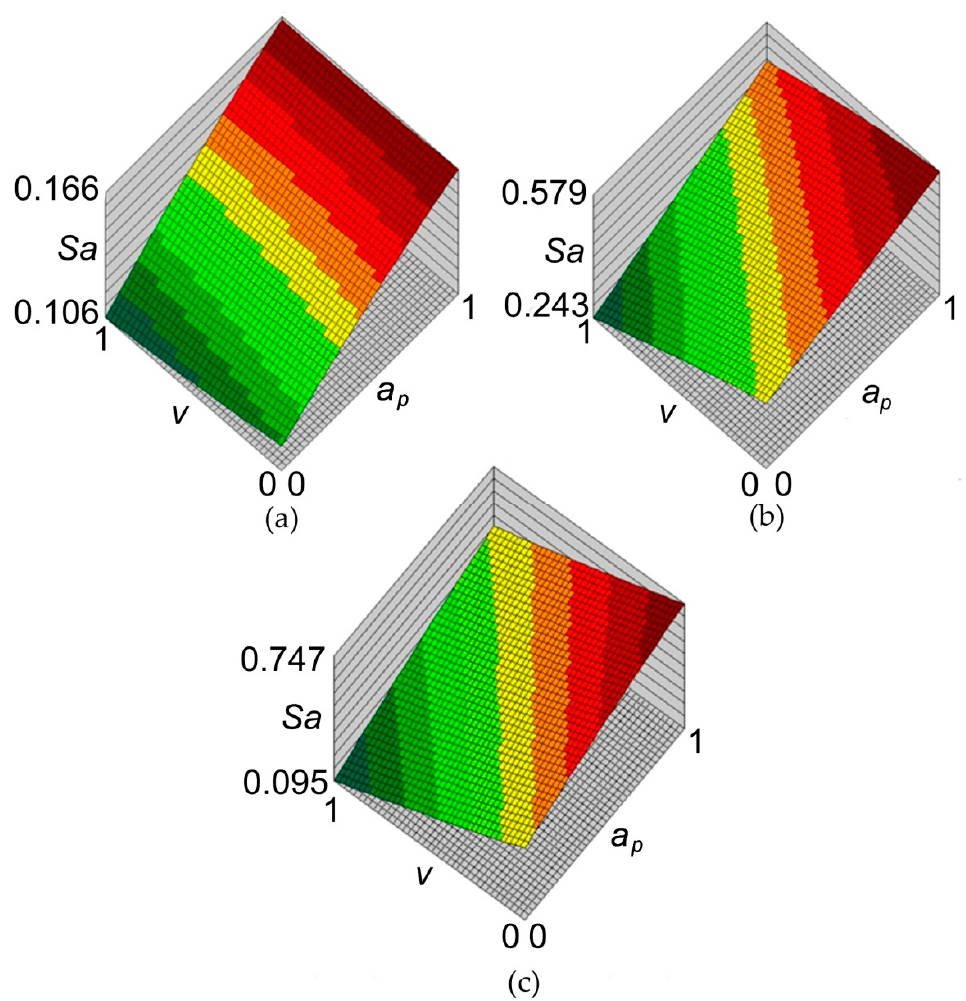
Figure 9. Response surfaces of the neural network 2:2-8-1:1 concerning the influence of incremental vertical step size a p and the tool rotational speed v on the value of the 10-point peak–valley surface roughness Sz (normalised data) for sheets: ( a ) 0.4-mm-thick EN AW-2024-T3 Alclad, ( b ) 1-mm-thick EN AW-2024-T3 and ( c ) 0.8-mm-thick EN AW-7075-T6 Alclad.